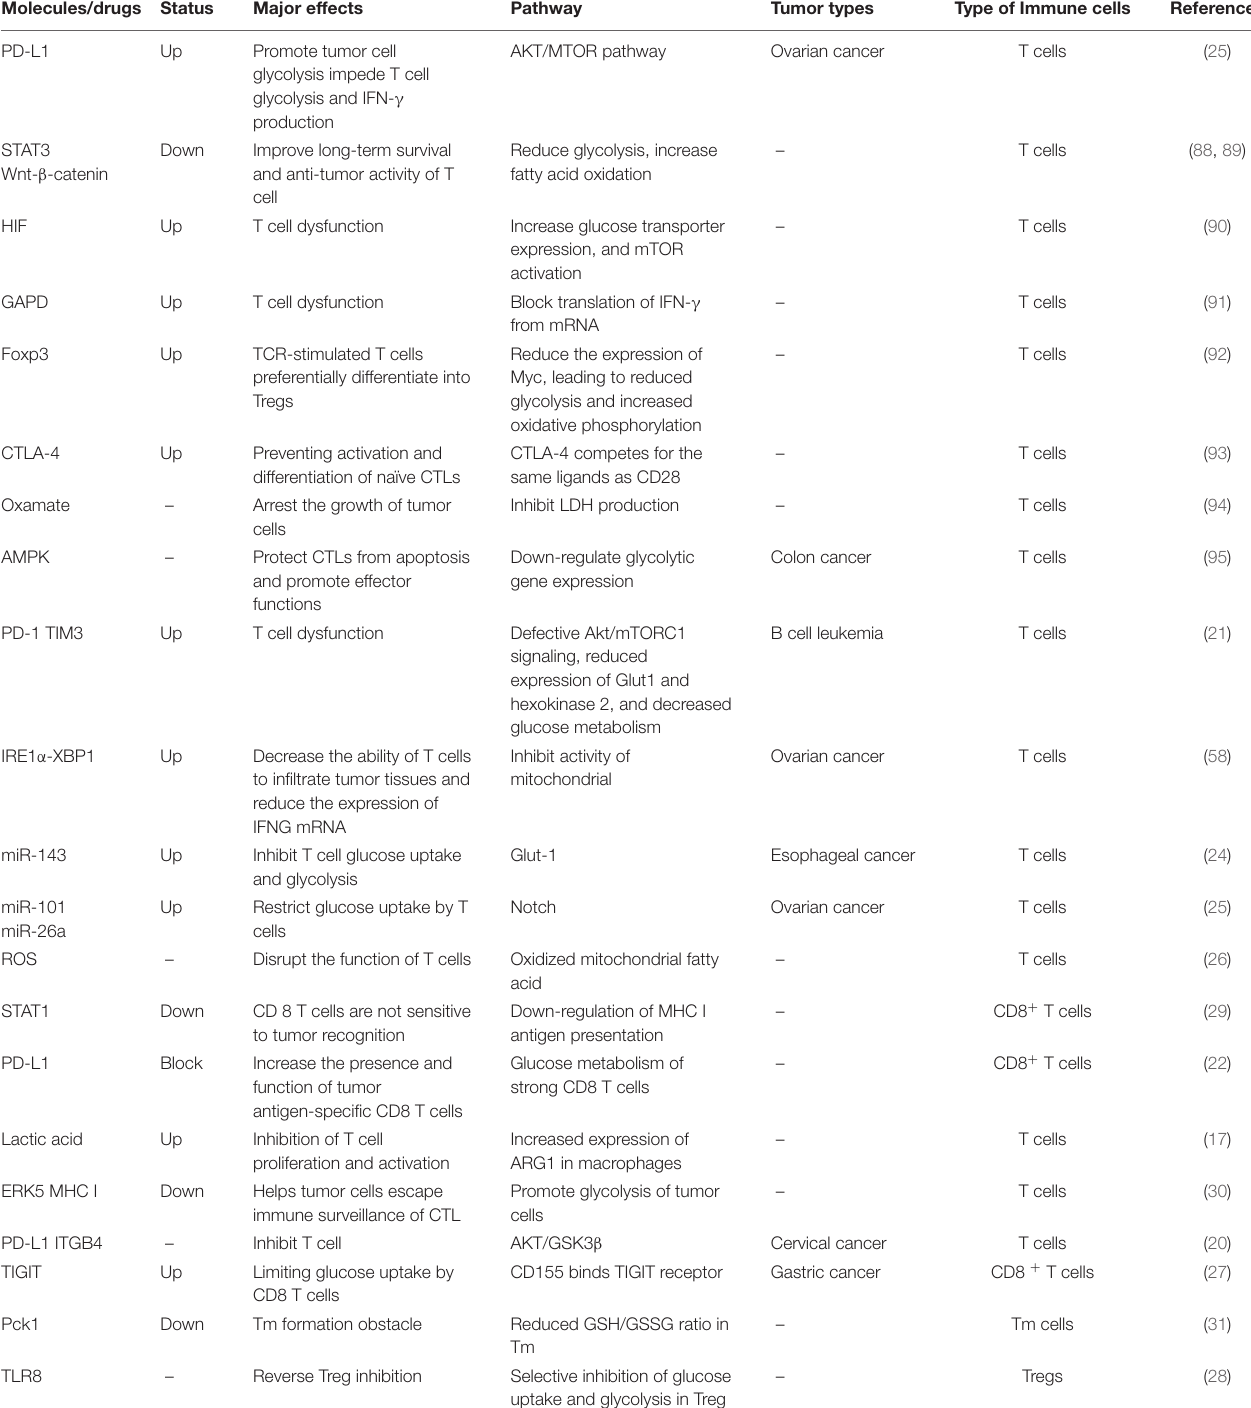
TABLE 1 | Glucose metabolism and tumor